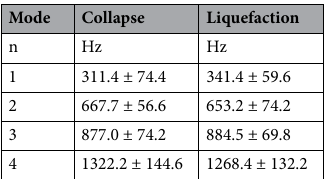
Table 1. Identification of vibrational modes of isotropic collapse and liquefaction instabilities by CCWT and the associated average frequency.